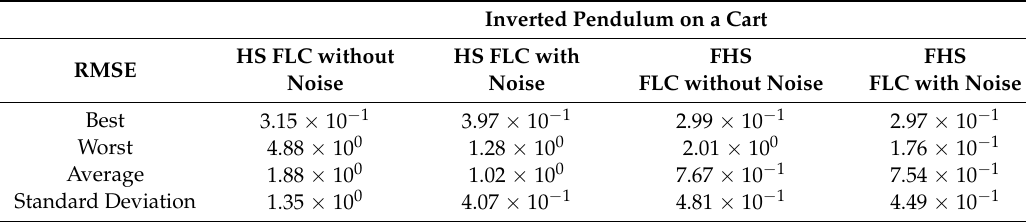
Table 11. Results obtained from the inverted pendulum controller by HS and FHS algorithms.